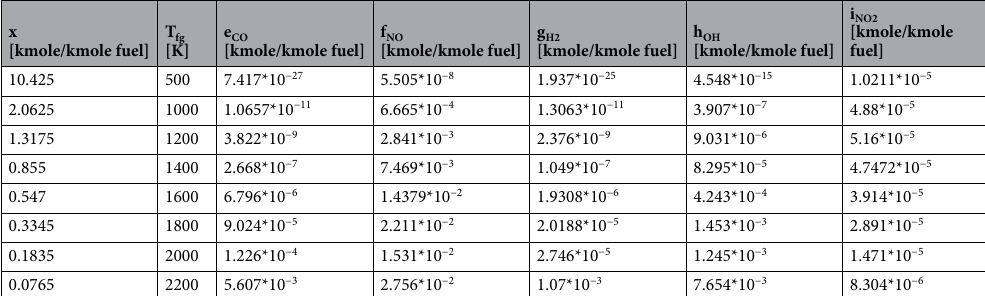
Table 8. The mole composition of flue gases function of temperature T fg , flow section “2”. p 2 = 0.8 MPa.